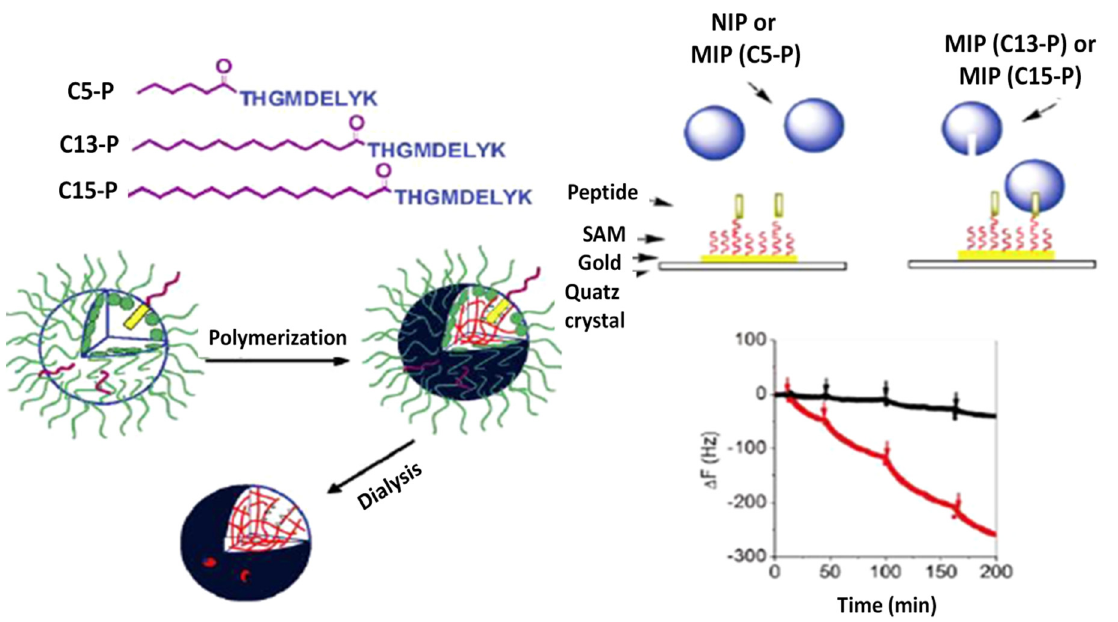
Figure 8. Schematic representation of the preparation protocol of the imprinted nanoparticles ( left ). Interaction between nanoparticles and immobilized peptide by QCM and the representative time courses of frequency change of the 27 MHz QCM ( right ). Copyright (2021) American Chemical Society [68].